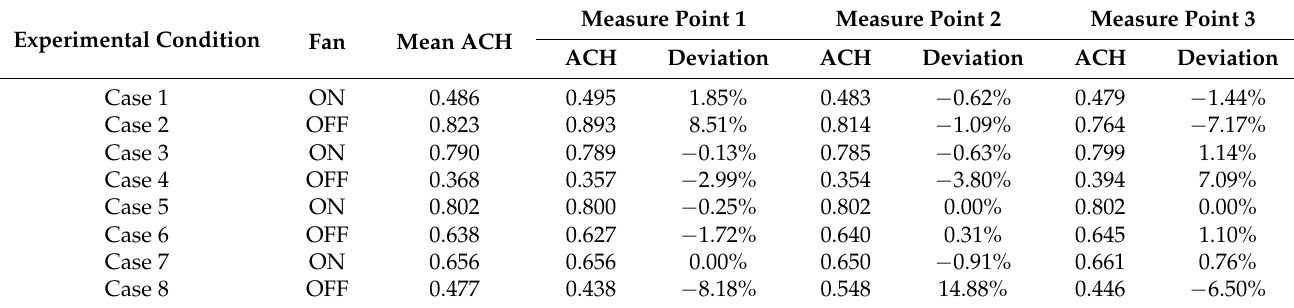
Table 6. Estimated results and deviations of AER in different experimental conditions based on